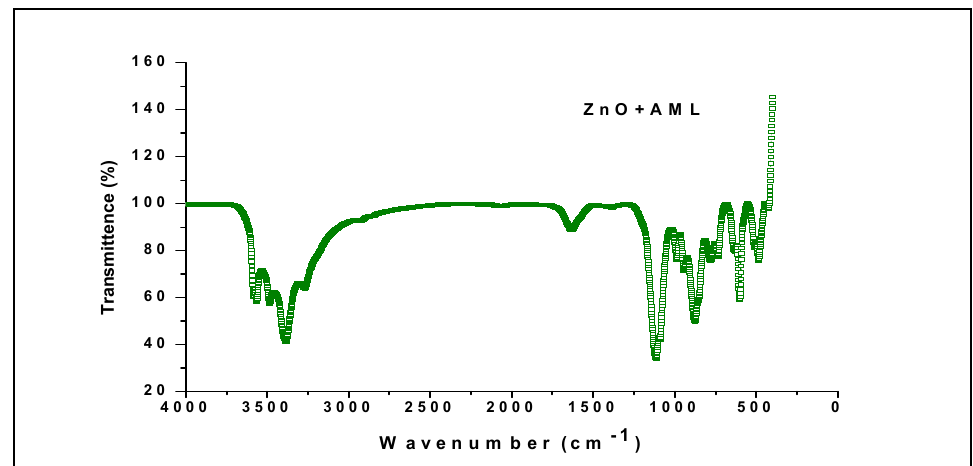
Figure 3. FTIR analyses of zinc oxide nanoparticles (ZNP).